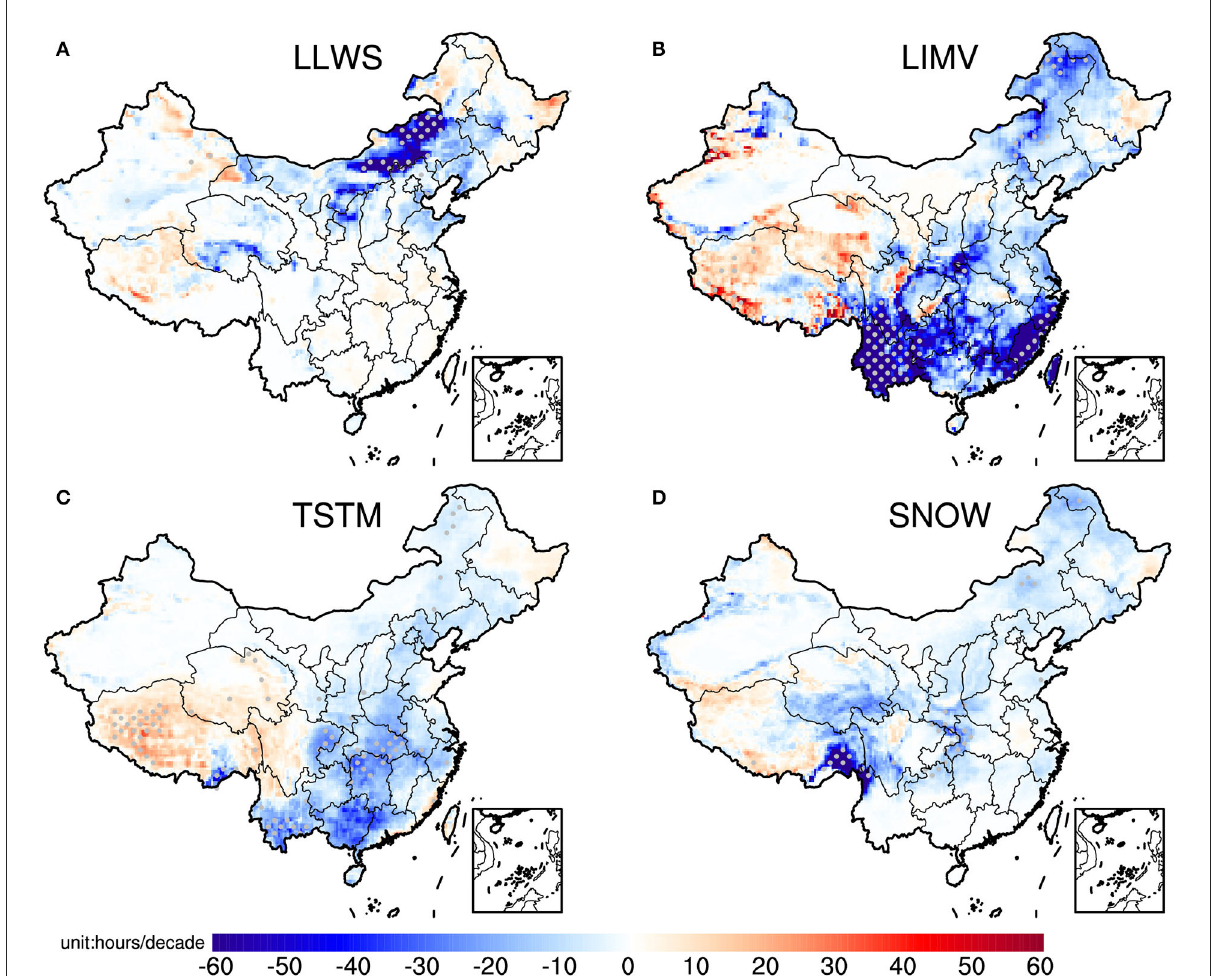
FIGURE8 Spatial distributions for the long-term trends in the numbers of hours with (A) LLWS, (B) LIMV, (C) TSTM, and (D) SNOW during 1979–2019. Dotted areas are statistically significant at the 95% confidence